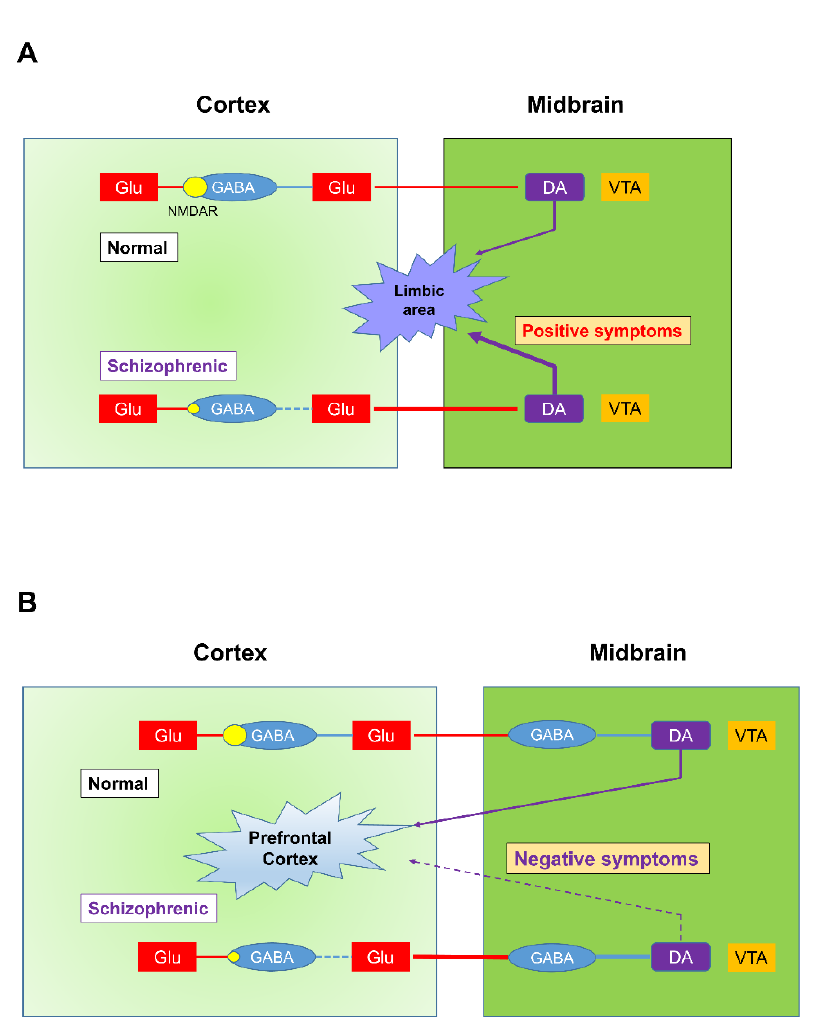
Figure 4. Differential involvement of multiple signaling systems in the manifestation of positive and negative symptoms of schizophrenia. According to recent studies on the mechanistic hypothesis of schizophrenia, signaling systems other than the DAergic system also play important roles. For example, abnormalities in the glutamatergic or GABAergic system could be involved in the dysregulation of the DAergic system, which is believed to be the final common pathway in schizophrenia. ( A ) Glutamate hypofunctioning hypothesis for the positive symptoms of schizophrenia. (Upper) Normal Glu-GABA-Glu neuronal circuitry with respect to mesolimbic DAergic projection. A pyramidal Glutamate neuron (the first neuron) synapses on a GABA interneuron (the second neuron), which next inhibits a secondary cortico-tegmental pyramidal glutamatergic neuron (the third neuron). These series of connections lead to the firing of mesolimbic dopaminergic neurons at the normal rate. (Lower) Abnormal Glu-GABA-Glu-DA neuronal circuitry. The NMDAR on the GABAergic neuron is suboptimal, and the second glutamatergic neuron is not inhibited properly, resulting in overactivation of the mesolimbic DAergic system that projects to limbic area. ( B ) Glutamate hypofunctioning hypothesis for the negative symptoms of schizophrenia. (Upper) Normal Glu-GABA-Glu-GABA neuronal circuitry with respect to the mesocortical DAergic pathway. In this pathway, another GABAergic connection is inserted between the cortico-tegmental glutamatergic and mesocortical DAergic neurons at the level of the brainstem. (Lower) In schizophrenia, a loss of NMDA activity on the first GABAergic neuron leads to consecutive activation of subsequent Glu-GABA neurons, which results in the inhibition of DAergic neurons located in the VTA. The decrease in DA input to the frontal cortex correlates with the negative symptoms of schizophrenia. Adapted from Reference [81].